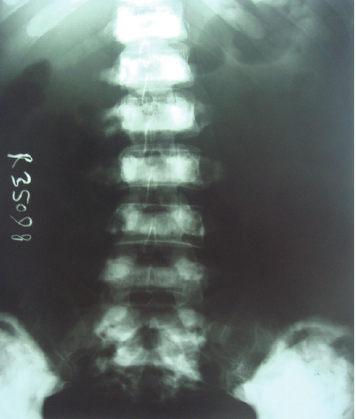
Figure 7: Anteroposterior view lumbar spine showing sclerosis at all the levels and “bone-in-bone appearance.”